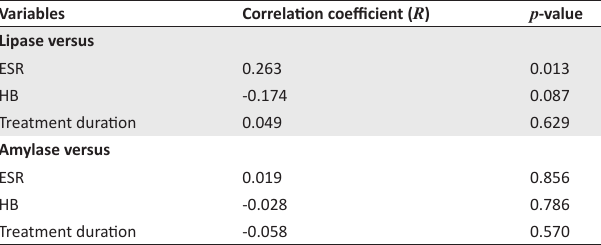
TABLE 2: Lipase and amylase Pearson correlation statistics in MTB patients versus other parameters.